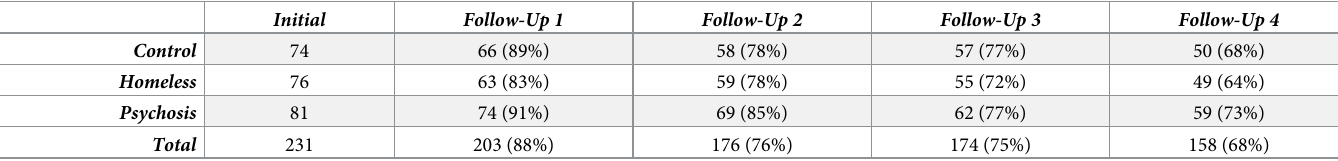
Table 1. Sample sizes for each group (and total across groups) at each follow-up period. Percentages in parentheses reflect the percentage of participants from the ini- tial assessment who took part in the respective follow-up.